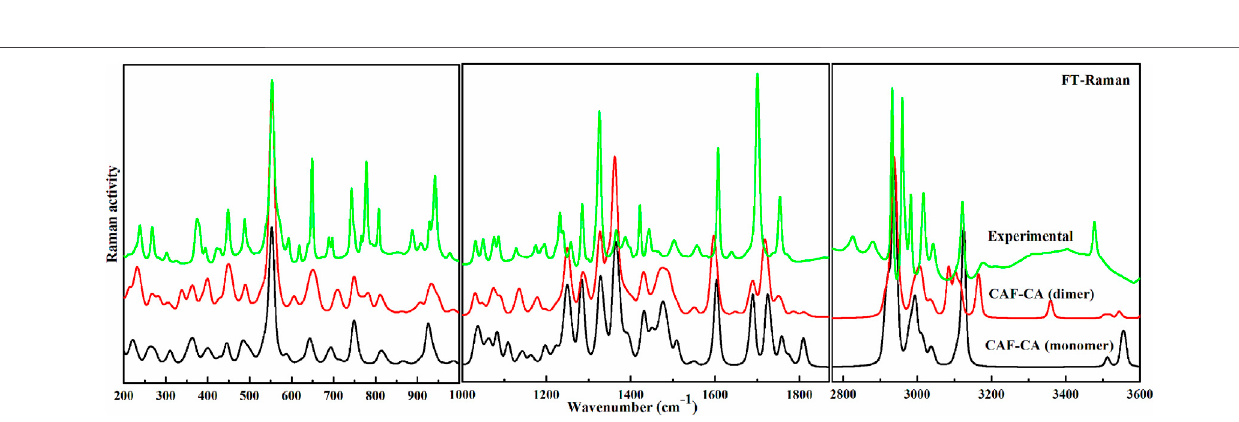
bond lengths and wavenumber values in dimer correlate well with the experimental data than CAF and monomer model of cocrystal.